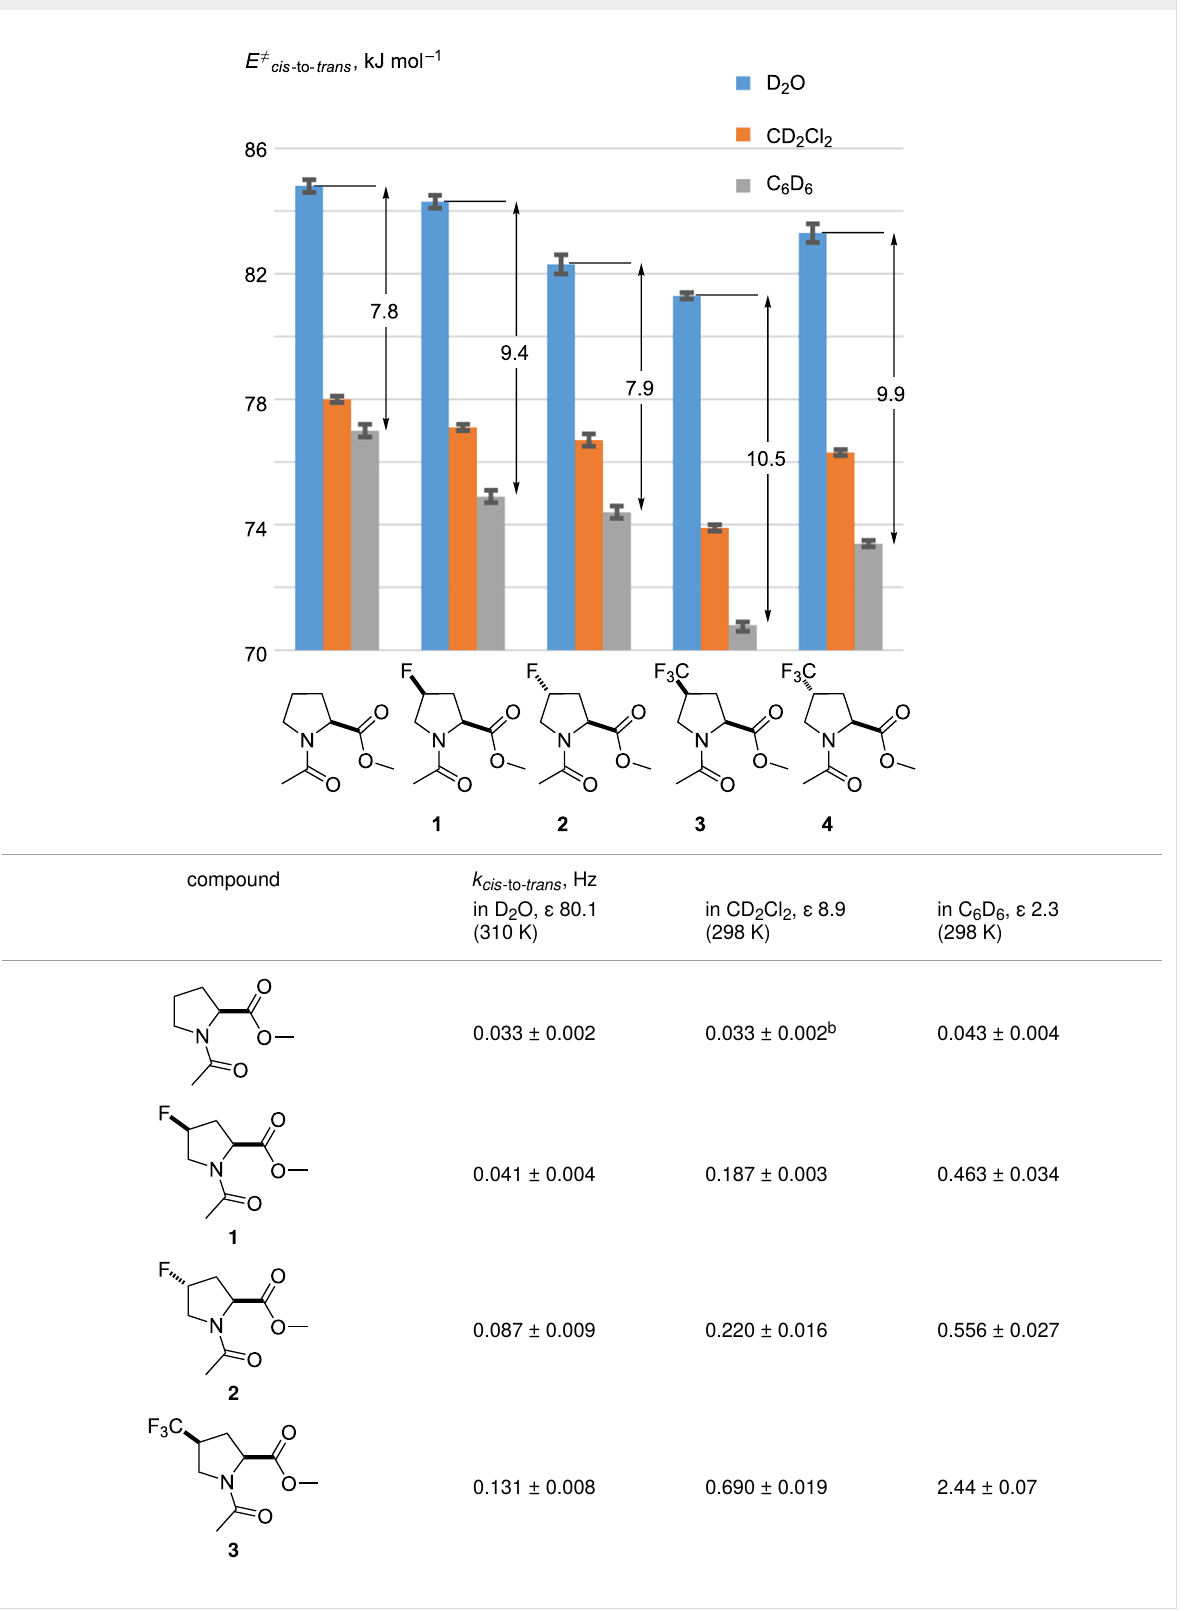
Table 3: Amide-rotation velocity in the model compounds.